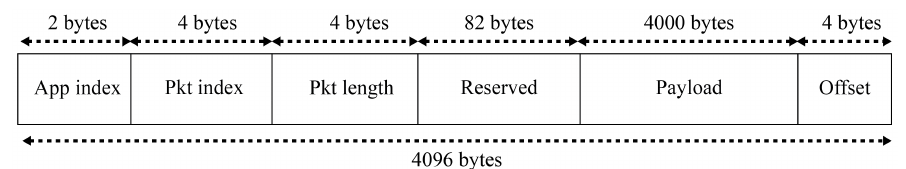
Figure 17. Packet structure of the mmWave connection.